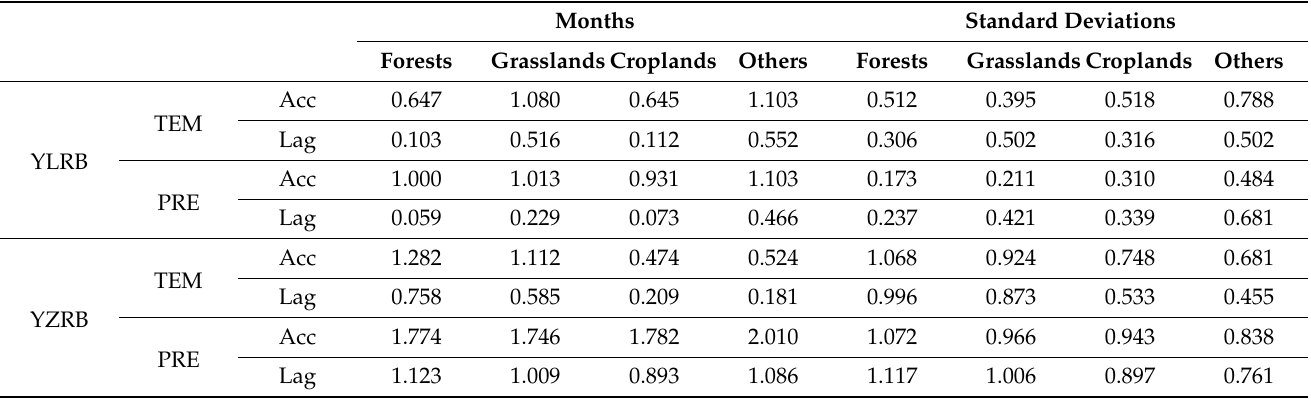
Table 4. Months and standard deviations of different vegetation types affected by time effects. Acc and Lag indicate time-accumulation and time-lag,